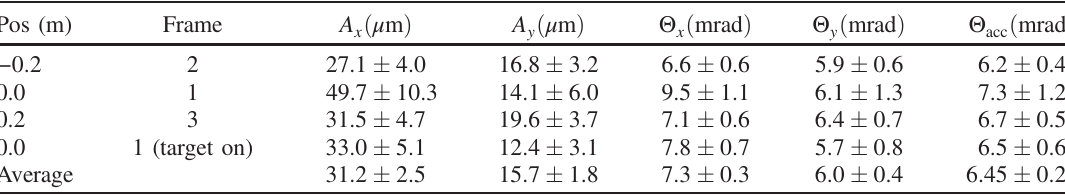
TABLE V. Acceptance measurements with the movable frame system, listing the acceptances A acceptance angles Θ and Θ , and Θ , using (6), (7), and the β -functions given in Table IV. One measurement with x y acc frame 1 was carried out with the cluster target switched on. The weighted averages are given in the bottom row. Results were rounded to one decimal place, while three decimal places were used for calculation and